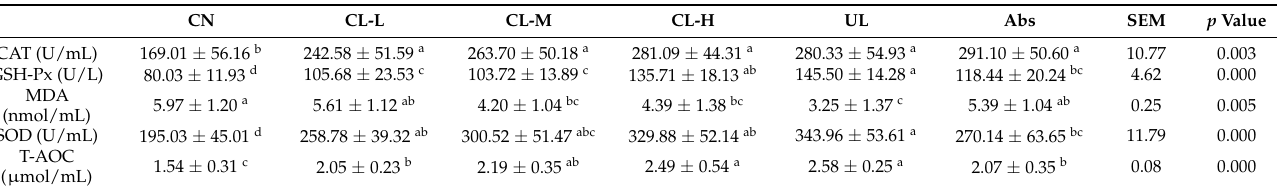
Table 2. Antioxidant indicators in serum.